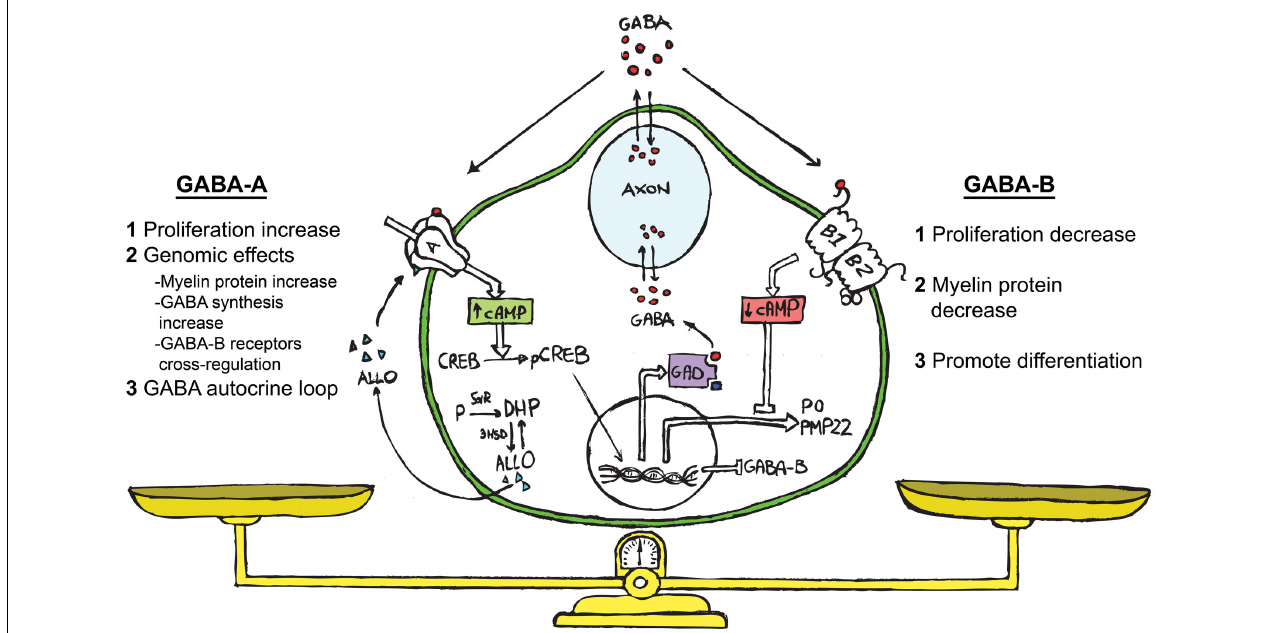
on the SC surface (Magnaghi et al., 2006).This modulates the expression and the responsiveness of the GABA-B receptor (Magnaghi et al., 2006, 2010), and in turn its desensitization. Contemporarily, ALLO stimulates the SC proliferation (Perego et al., 2011), inducing other genomic effects such as the increase of myelin proteins (Melcangi et al., 1999a; Magnaghi et al., 2001), and the rising of GAD and GABA levels (Magnaghi et al., 2010).The last effect, being a sort of autocrine mechanism, involving enhanced cAMP levels and the PK-A pathway. Collectively, these findings suggest that an autocrine mechanism involving ALLO and GABA is particularly relevant for the control of SC proliferation/differentiation, and may be considered the result of a balanced activation of GABA-A or GABA-B receptors on